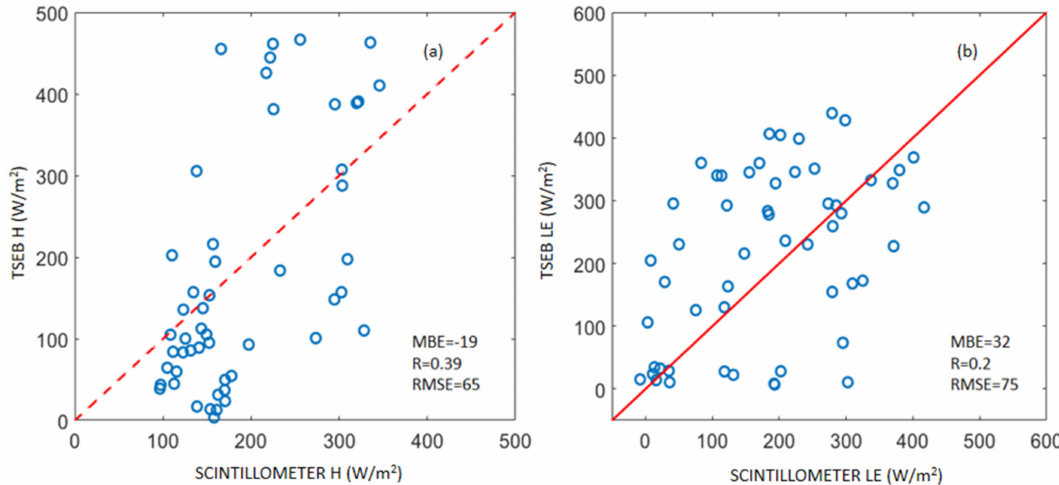
Figure 8. Sensible ( a ) and latent ( b ) heat fluxes scatterplots of the comparison between the LAS grid scale measurements and TSEB predictions based on MSG SEVIRI products (at MSG-SEVIRI overpass